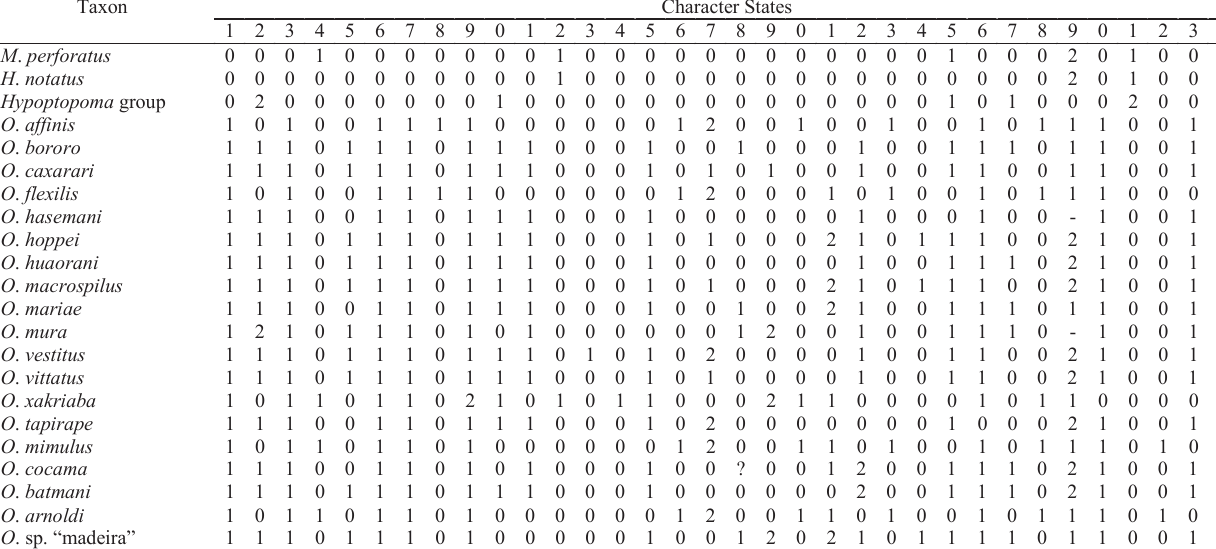
Table 3. Data matrix of characters for Otocinclus species and outgroups. Characters 1-27 from Schaefer (1997), character 28 from Axenrot & Kullander